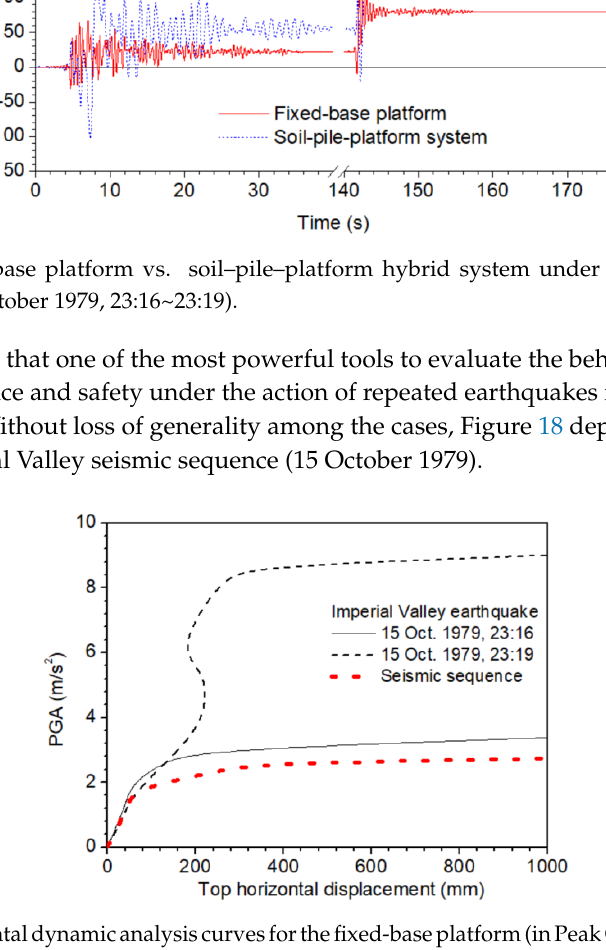
Figure 18. Incremental dynamic analysis curves for the fixed-base platform (in Peak Ground Acceleration – PGA – terms) under the Imperial Valley earthquake (15 October 1979, 23:16 and 23:19): single seismic events vs. seismic sequence .